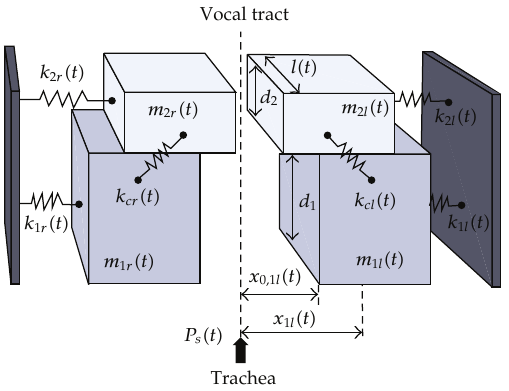
Figure 7: Two-mass models of the asymmetric vocal folds with time variable parameters (cid:4) 46 (cid:5) .